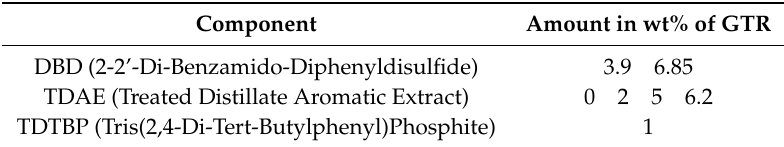
Table 2. Devulcanization formulations used for continuous